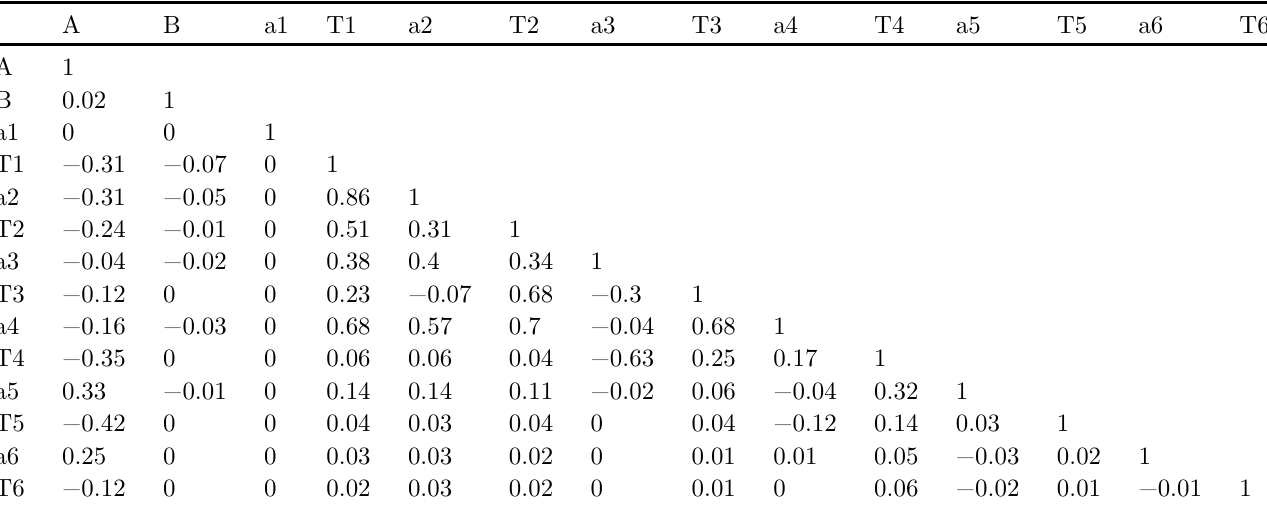
Table 11. The 6-group correlation matrix obtained in the LSF processing of the model decay curve calculated with the help of the estimated 6-group DN parameters from fi ssion of 235 U by thermal neutrons.